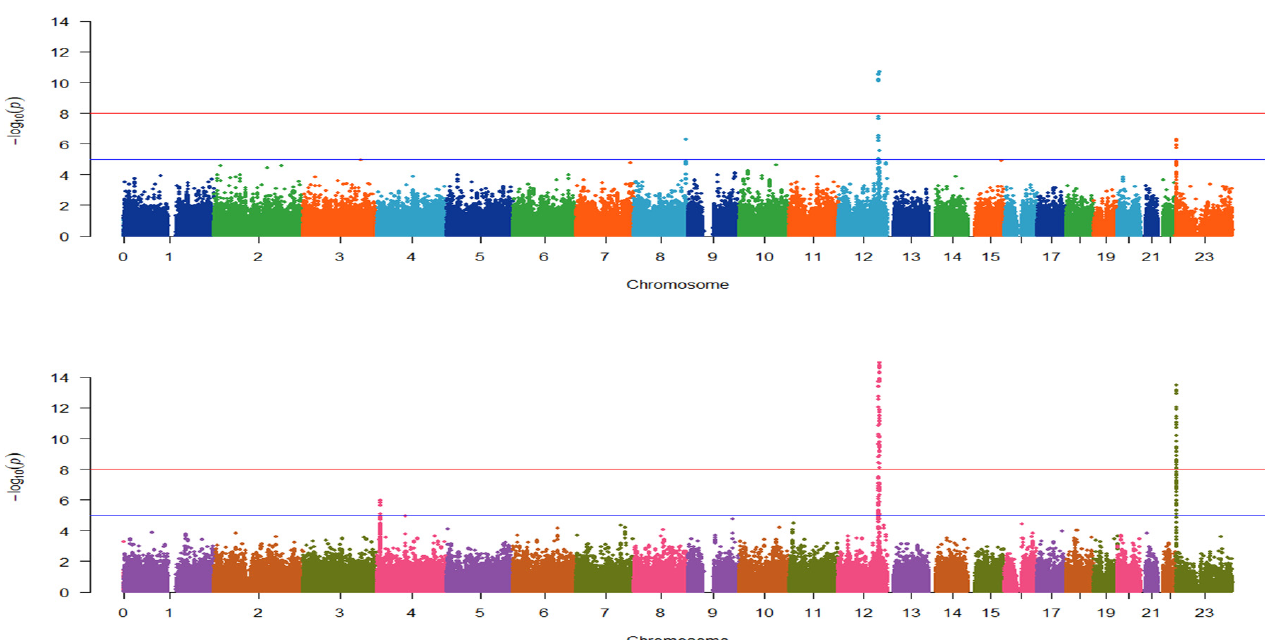
Figure 2. Manhattan plot of the association between drinkers and non-drinkers. (Top) Among 8468 subjects, 1543 subjects had at least chronic cardiovascular diseases (CVDs). In the CVD group, 923 were drinkers and 620 were non-drinkers. (Bottom) In the non-CVD group, 3656 were drinkers and 3269 were non-drinkers. The plot shows − log10 p value for each SNP against the chromosomal location.